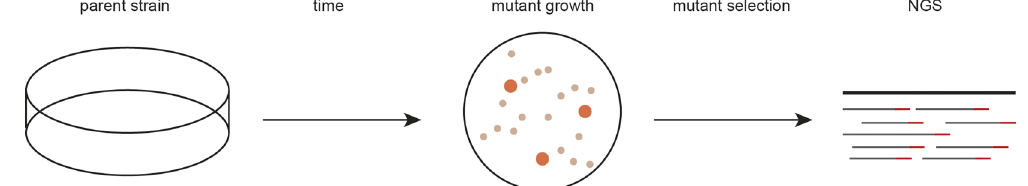
Figure 1. Schematic illustration of the experimental set-up. The parental strain is incapable of using the carbon source available in the plates, but after some days on plates, mutants adapted to their environment appear. These mutants are collected and subjected to next-generation genome sequencing (NGS).